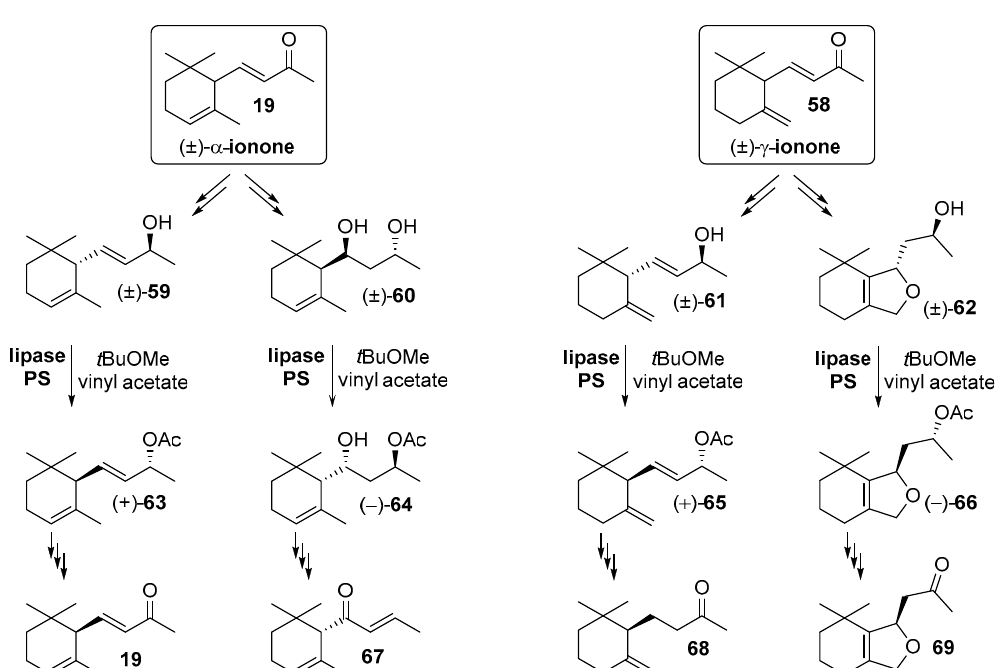
Figure 12. Lipase-mediated resolution of the racemic ionol derivatives 59 – 62 , applied to the enantioselective synthesis of the apocarotenoids α -ionone ( 19 ), α -damascone ( 67 ), γ -dihydroionone ( 68 ), and 7,11-epoxymegastigma-5(6)-en-9-one ( 69 ).